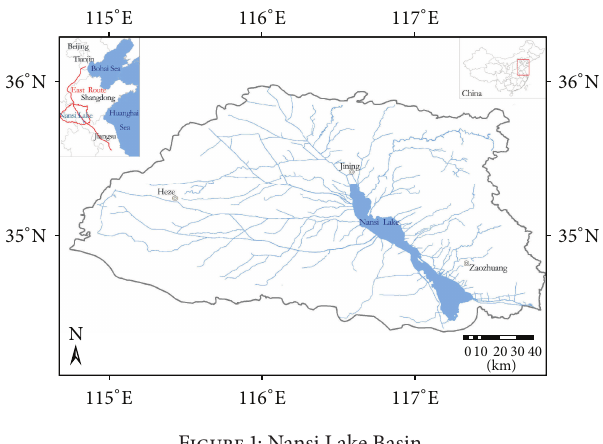
Figure 1: Nansi Lake